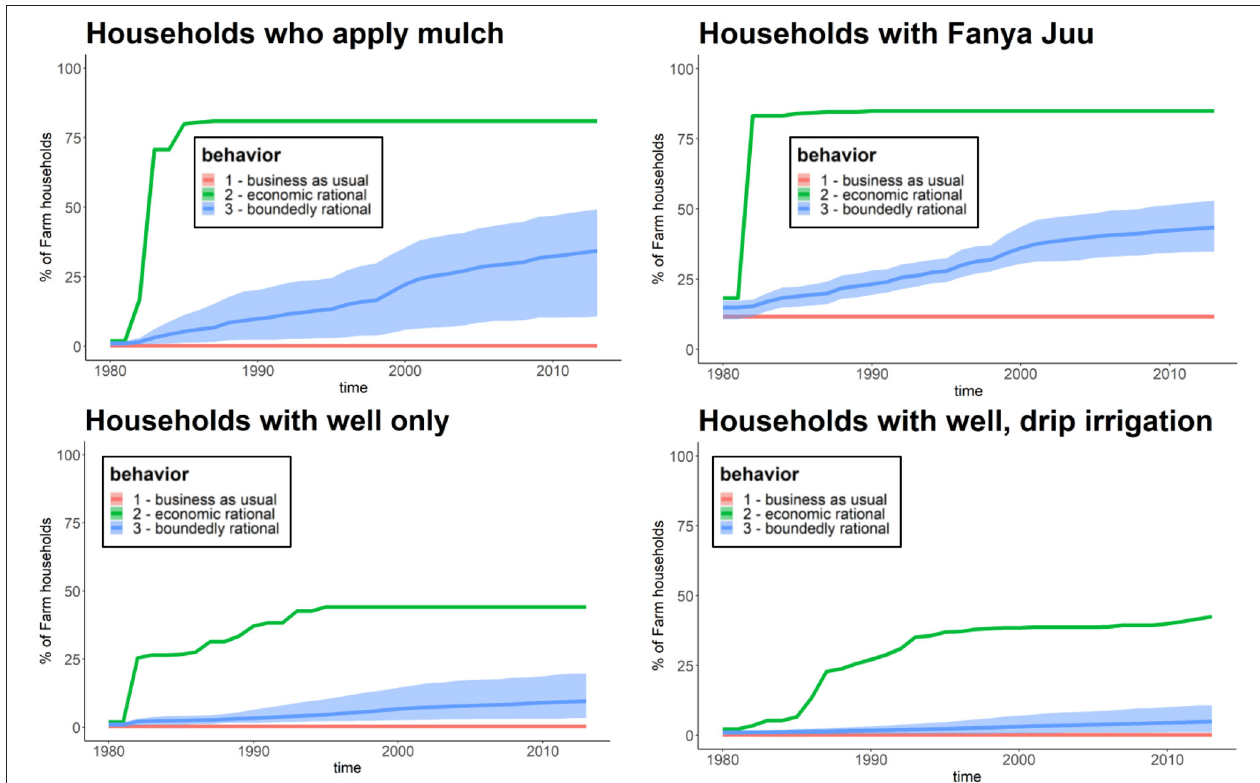
FIGURE 3 | Adoption of different drought adaptation measures over time, for three behavioral scenarios—economic rational (EUT, green), bounded rational (PMT, blue), and business as usual/no adaptation (red)—and for four different drought adaptation measures (fanya juu terraces, mulching, manual irrigation, and drip irrigation). Shaded blue areas show the variance across 48 bounded rational model runs, a result of the variety in weights of the PMT